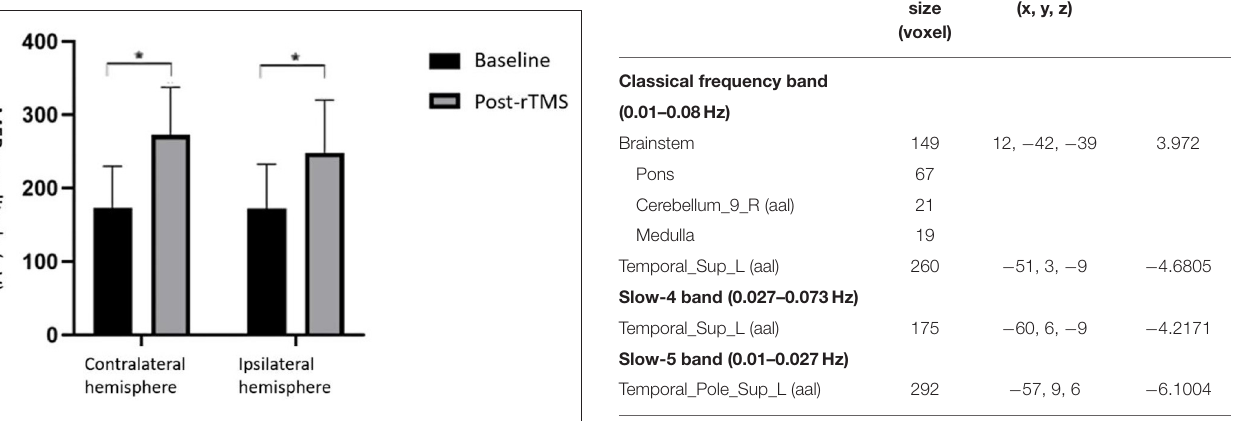
Frontiers in Human Neuroscience |